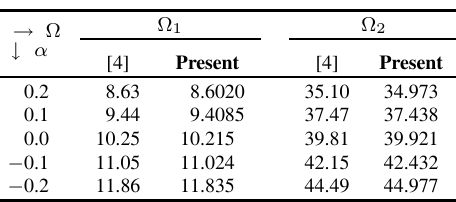
Table 5 Comparison of Ω for C -plate when β =